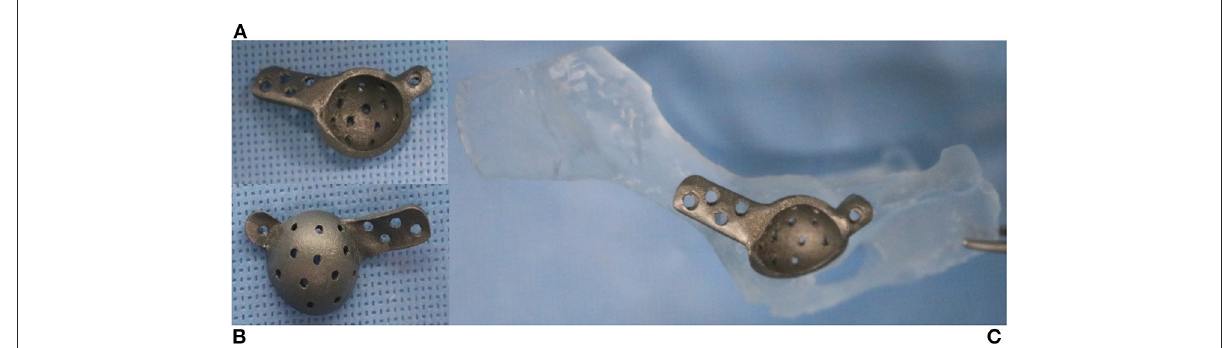
FIGURE2 Three-dimensionally printed pelvic bone and acetabular implant. Lateral (A) and medial (B) aspects of the cage. Two flanges provide screw holes to achieve initial fixation to the ilium and ischium (C) . The medial side of the implant has a porous surface for long-term biological fixation.